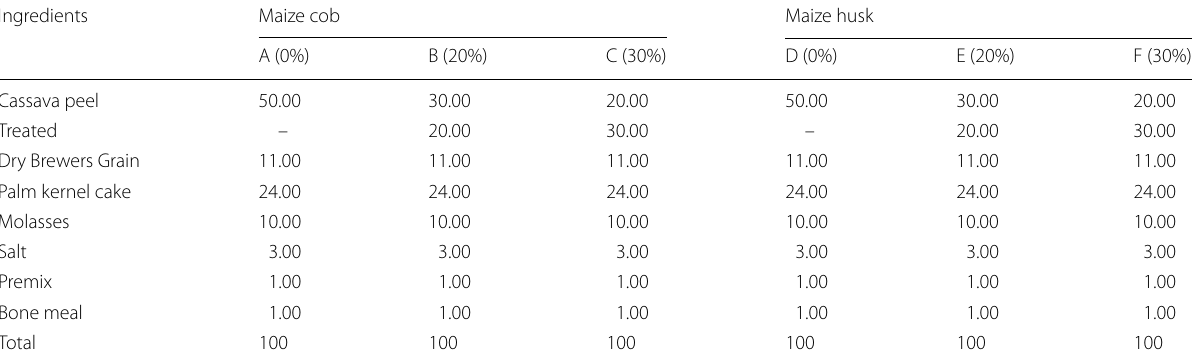
Table 1 Gross composition of treated maize cob- and maize husk-based diets with mixture of microorganisms Ingredients